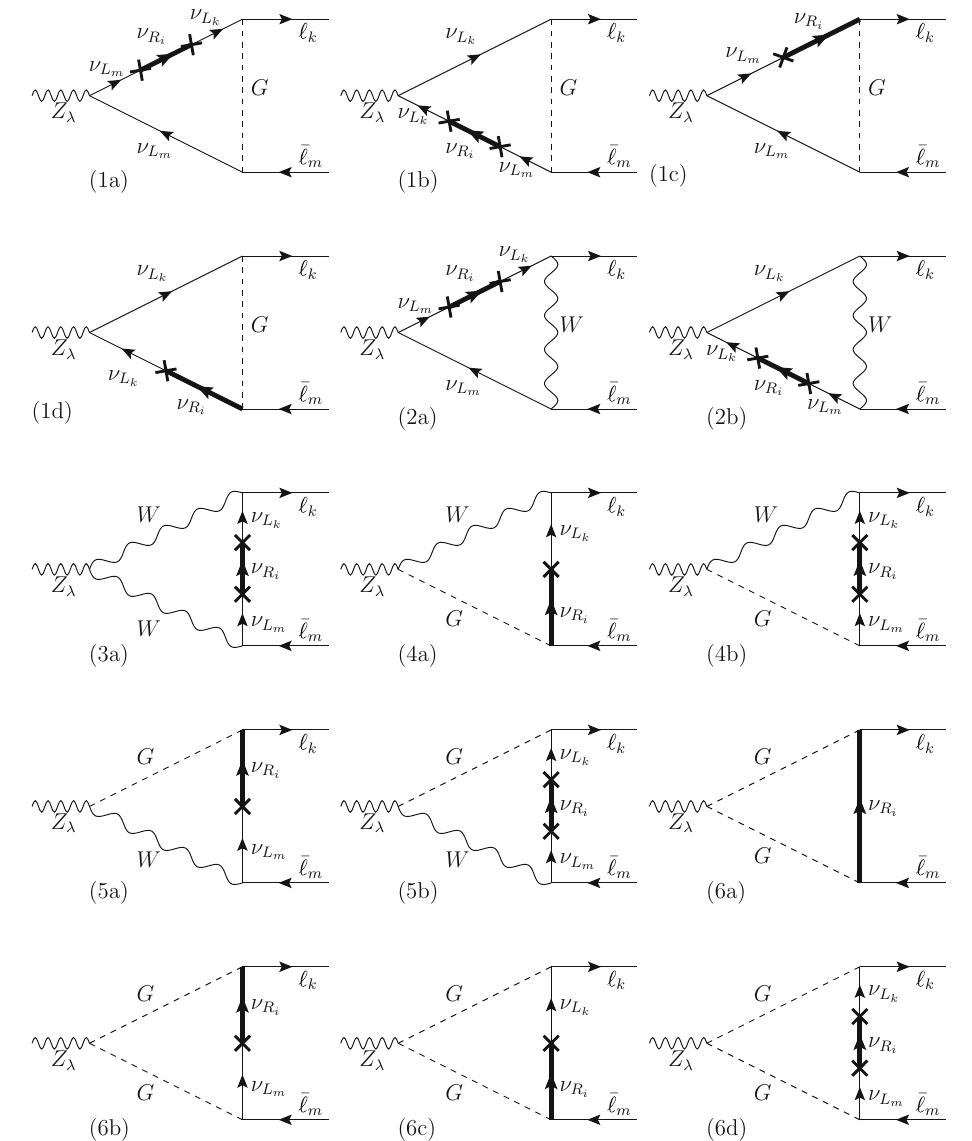
Fig. 2 Relevant diagrams of O ( Y 2 ν ) in a covariant gauge corresponding to vertex